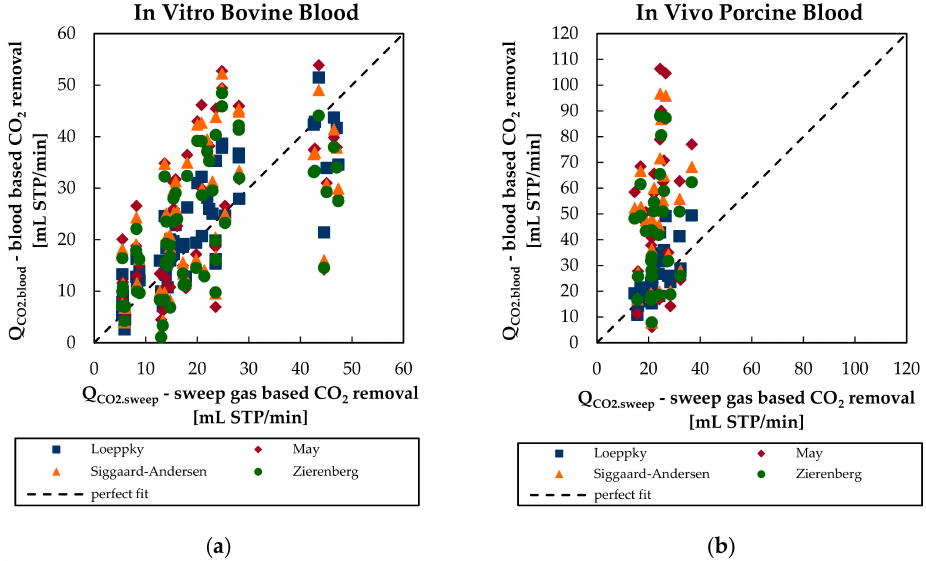
Figure 6. Blood-based CO 2 removal rate of the four CO 2 solubility models in dependency of the sweep flow-based CO 2 removal rate for ( a ) in vitro bovine blood tests and ( b ) in vivo porcine blood